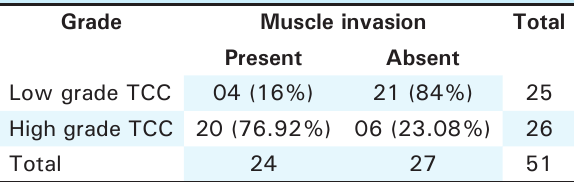
Table 5. Grade and muscle invasion in